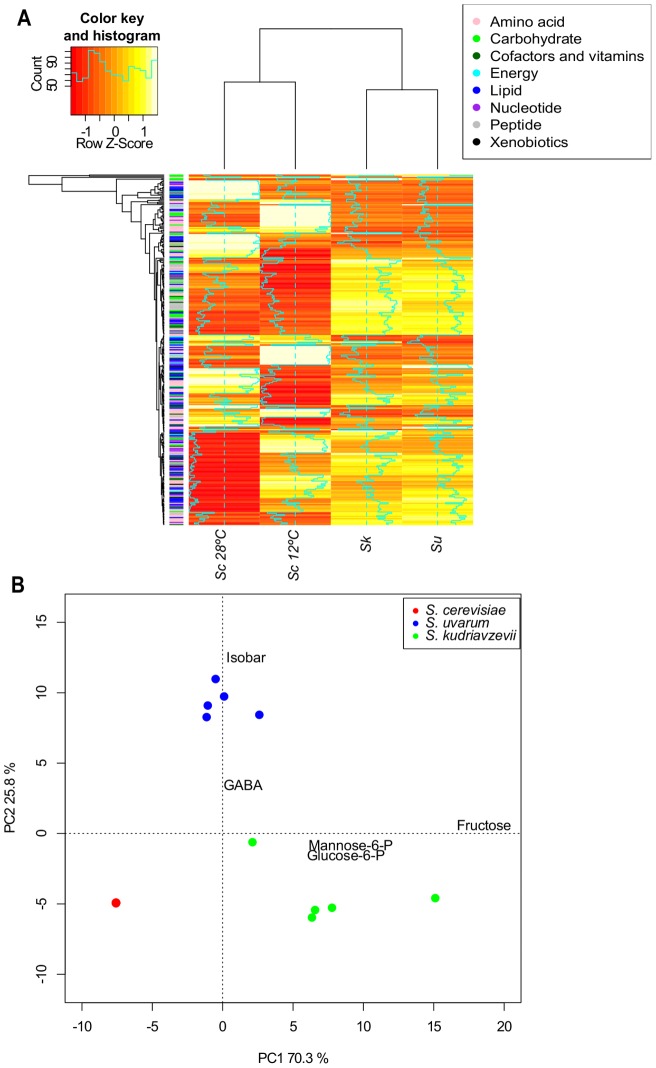
Global biochemical profiles comparison made of the three species.
A) Hierarchical clustering of all the species is computed after standardizing metabolites to the Z-score. B) Biplot of the first two components of the PCA according to the metabolic composition. Isobar  =  isobaric compounds fructose 1,6-diphosphate, glucose 1,6-diphosphate and myo-inositol 1,4 or 1,3 diphosphate.